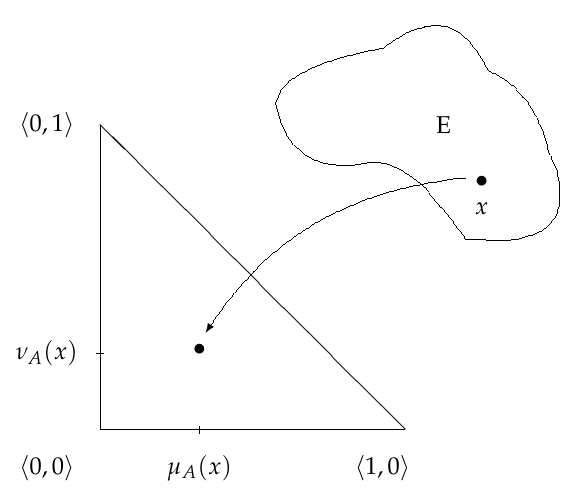
Figure 1. The second geometrical interpretation of an intuitionistic fuzzy set (IFS).